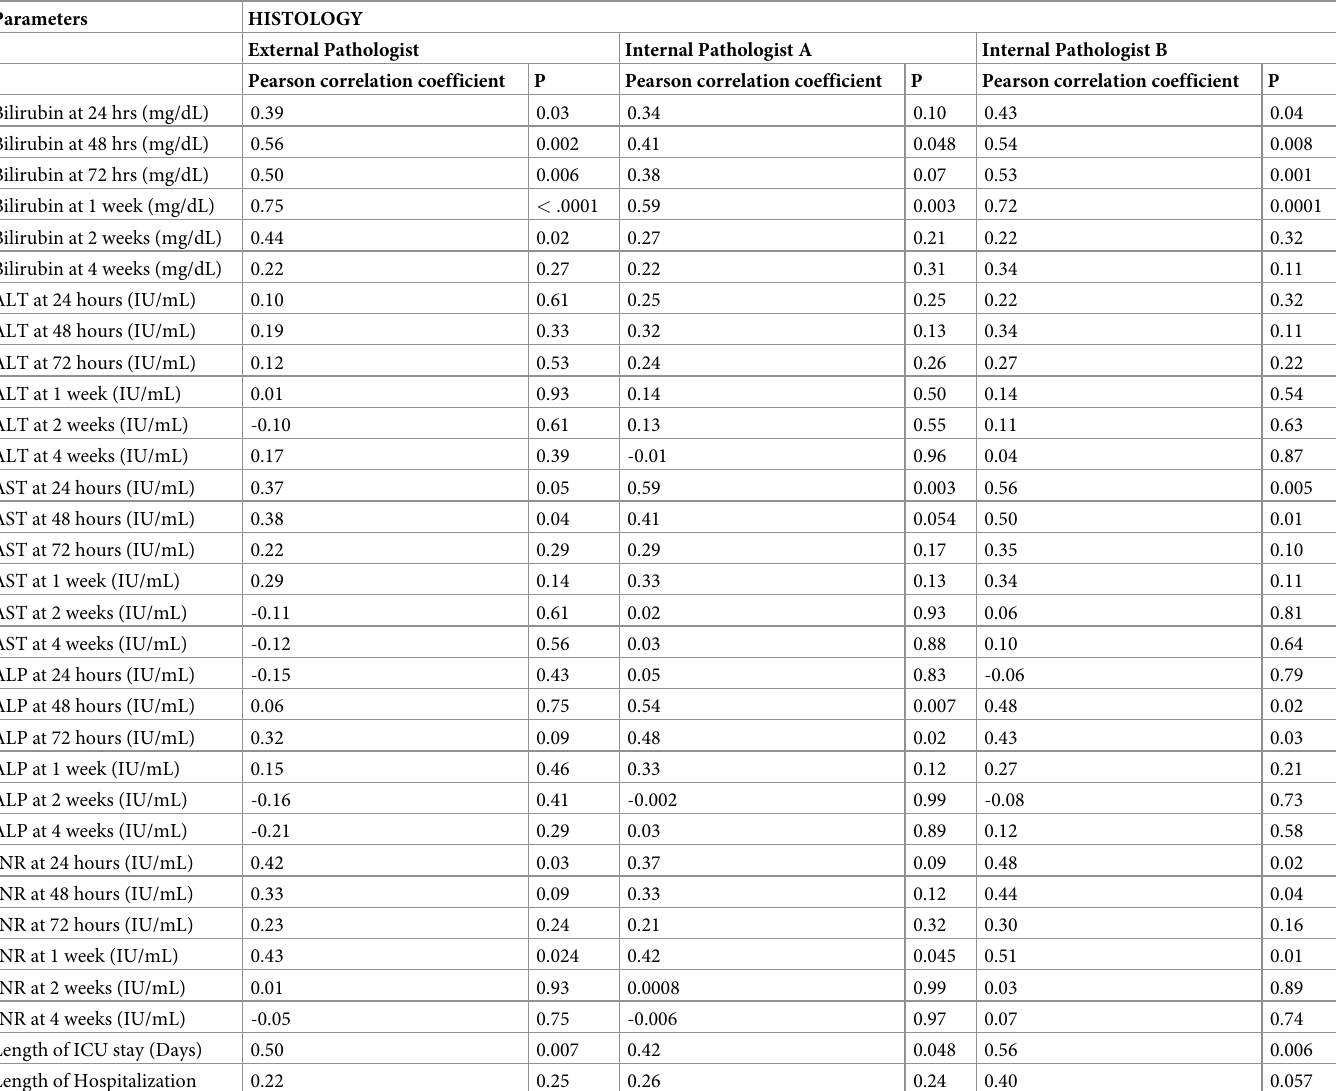
Table 4. Correlations of early post-transplant liver chemistry, and clinical outcomes based on hepatic fat quantification by histology.